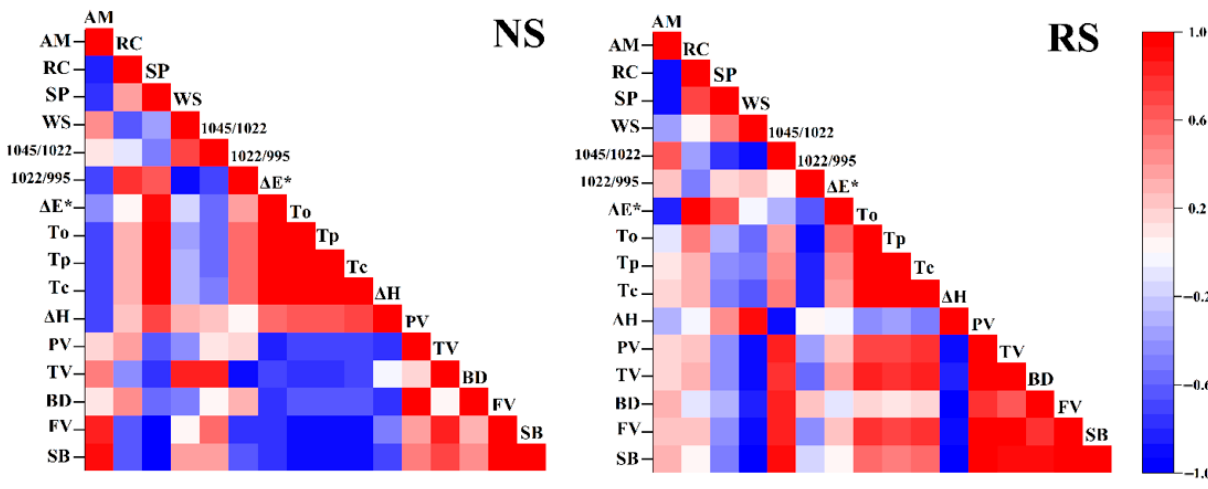
Figure 6. Pearson’s correlation coefficients between structural and physicochemical properties of the NS (natural starch) and RS (resistant starch) samples. WC, water solubility; SP, swelling power; RC, relative crystallinity; AM, amylose con- tent.